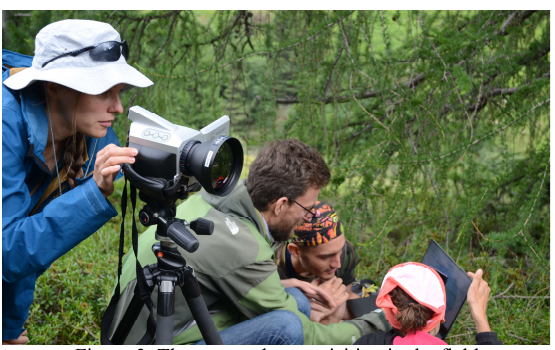
Figure 3. Thermography acquisition in the field